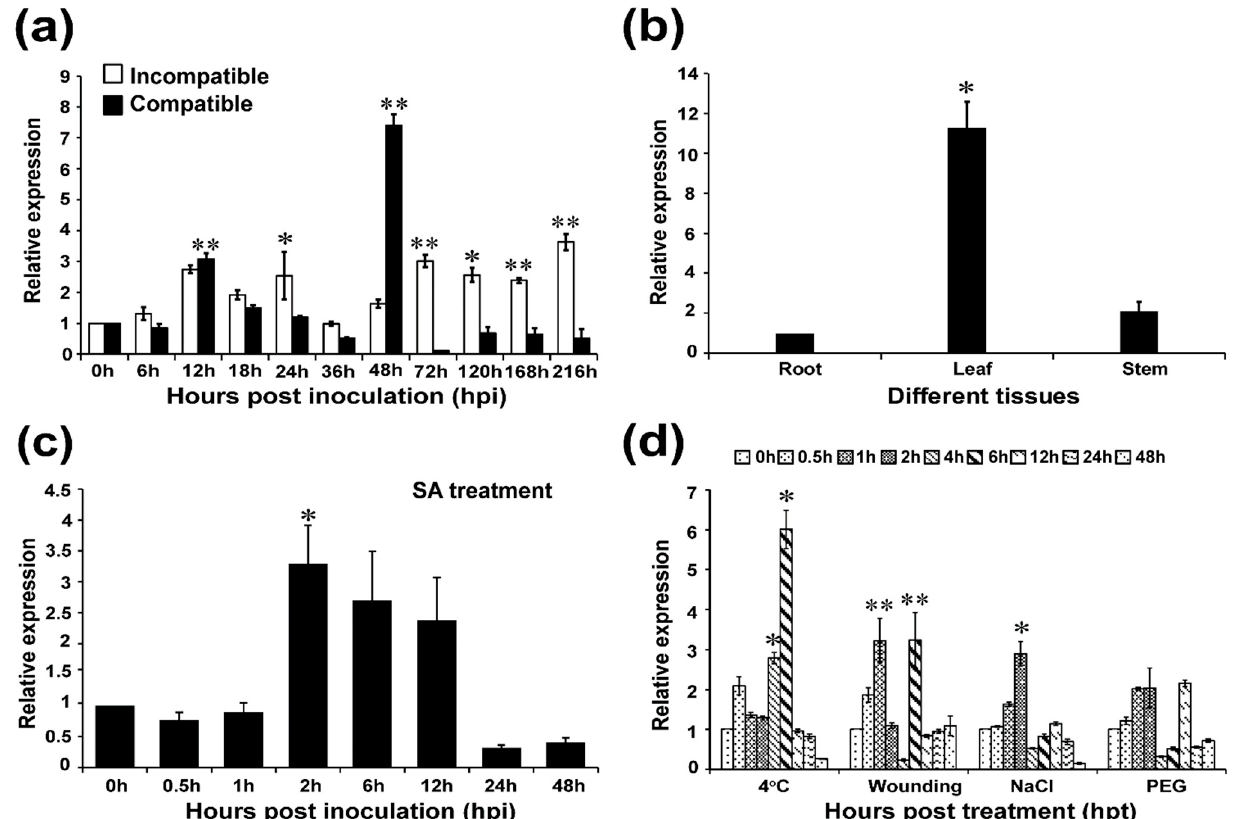
Figure 2. TaAP2-15 is induced by multiple stresses. ( a ) TaAP2-15 is induced in wheat leaves upon infection with Pst isolates, CYR23 (incompatible) and CYR31 (compatible) at diverse time points; ( b ) Expression of TaAP2-15 in three wheat organs (root, leaf and stem), ( c ) Exogenous application of 2 nM SA in wheat leaves induced the expression of TaAP2-15 , ( d ) The expression of TaAP2-15 in wheat leaves is enhanced when treated with environmental stress (low temperature, wounding, salt and drought). Two-weeks-old wheat seedlings were used in all experiments. TaEF-1 α was used as internal reference. Samples taken at each time point (uninoculated and untreated plants) were used as controls. Relative quantity of expression of TaAP2-15 was computed via the comparative threshold (2 − ∆∆ C t ) method. The transcript levels were quantified by qRT-PCR and the values were standardized to those for TaEF-1 α and presented as relative changes to untreated plants. The expression level of TaAP2-15 at time 0 h was normalized as 1. Statistical variations were analyzed using Student’s t -test. *, p < 0.05, **, p < 0.01. All data were obtained from three biological replicas.